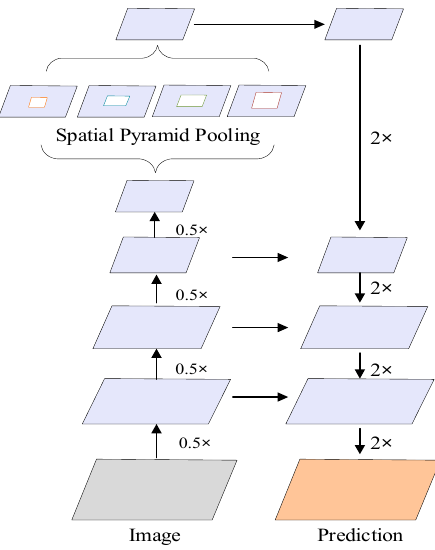
Figure 5. Vertical structure of semantic segmentation of underwater images.